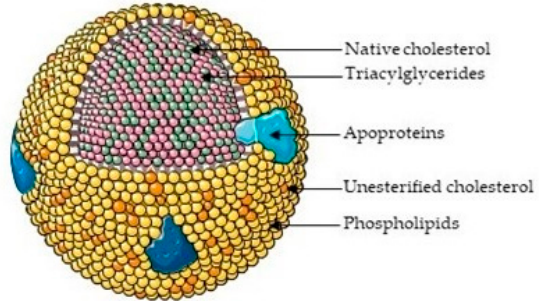
Figure 1. Lipoprotein structure—an overview. Lipoproteins are a spherical monolayer of amphipatic phospholipids (yellow) and free/unesterified cholesterol (orange). The tails of the phospholipids create a hydrophobic core of non-polar lipids, primarily cholesterol esters (green) and triglycerides (pink), surrounded by a hydrophilic membrane of phospholipids, free cholesterol and apolipoproteins (blue). Lipoproteins differ in their lipid composition, size, density, major apolipoproteins and function [53]. Figure produced using Servier medical art [54].